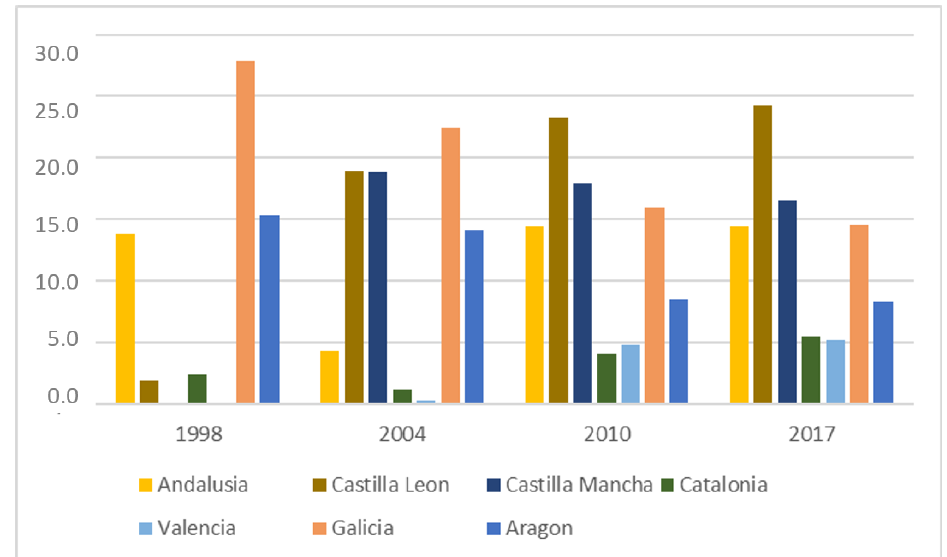
Figure 2. Installed wind power and principal legislation Spain (1995 – 2017) elaborated from [69].